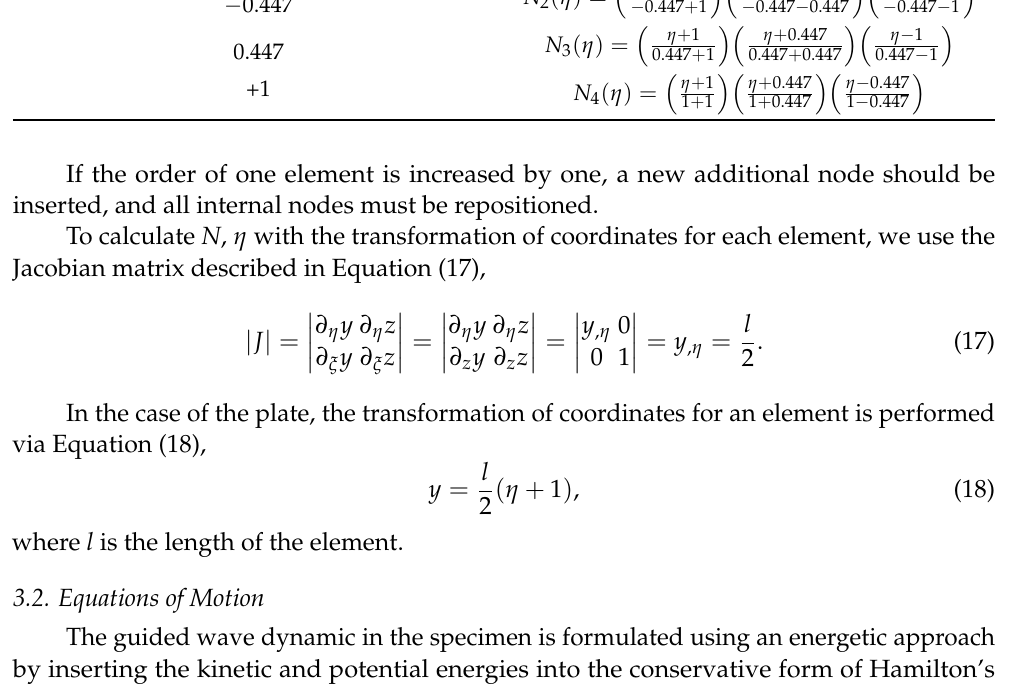
Table 2. Shape functions for p = 3 and 4 nodes (order 3). η i Shape Functions N −